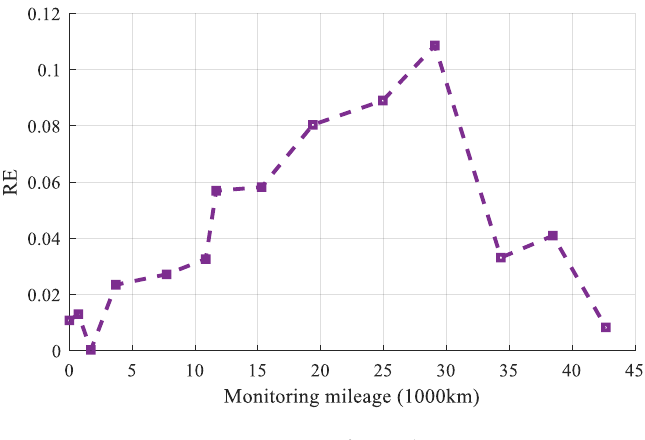
Figure 13. Appl. Sci. 2020 , 10 , x FOR PEER REVIEW